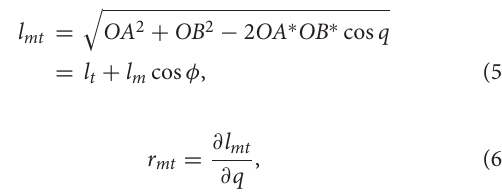
length, Equation (12) is